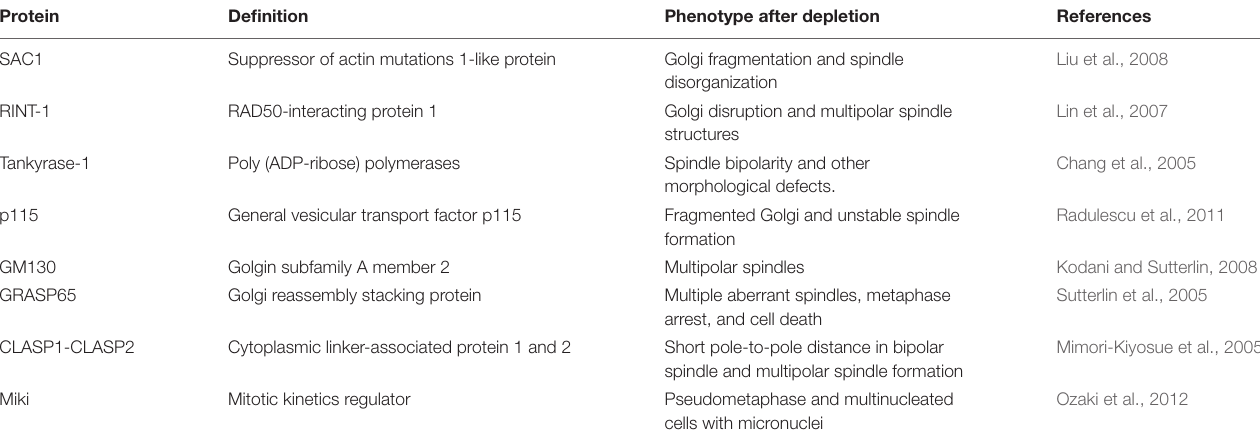
TABLE 1 | Golgi located proteins involved in spindle